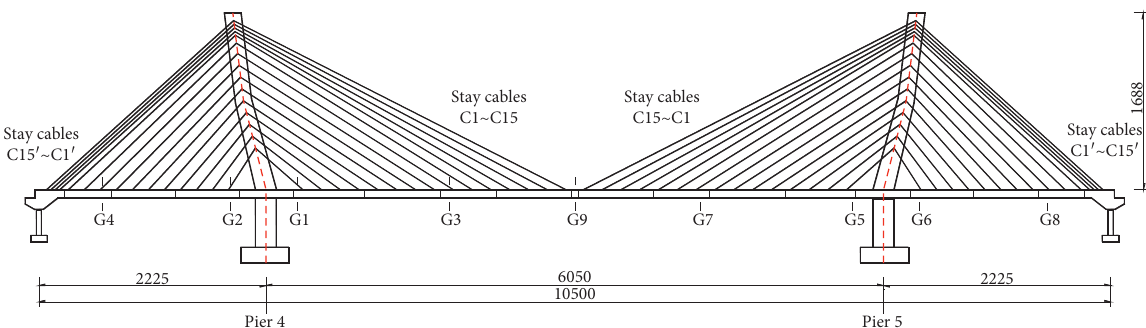
Figure 4: Diagram of testing section arrangement about girder (unit: mm).